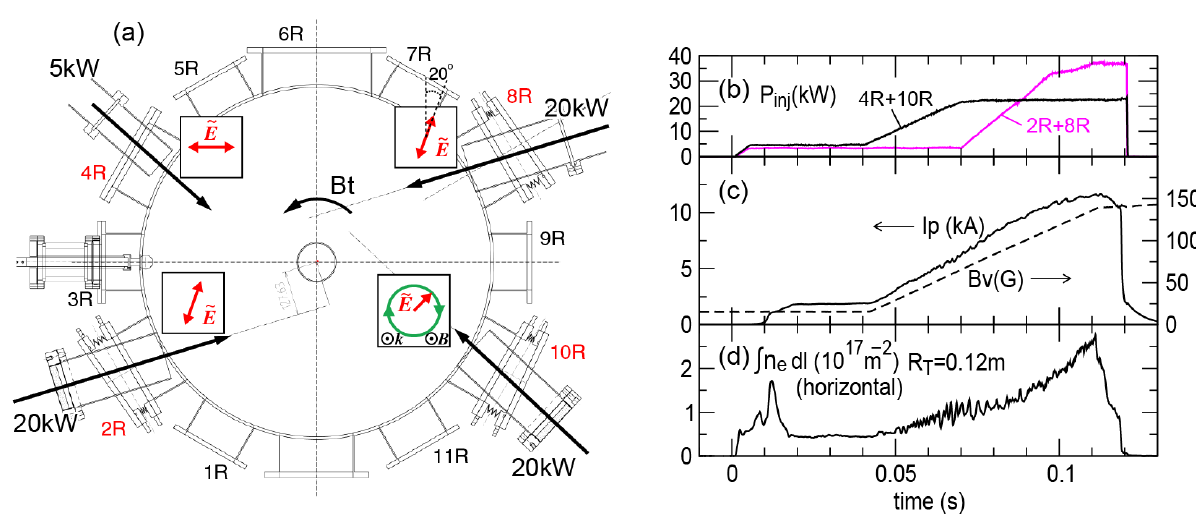
Figure 4. Time traces of (a) injection power of O-mode like polarization (black) and X-mode like one (red), (b) plasma current and vertical filed, (c) holizontal chord line-integrated density at a tangency radius of Rt = 12 cm. (d) Injection